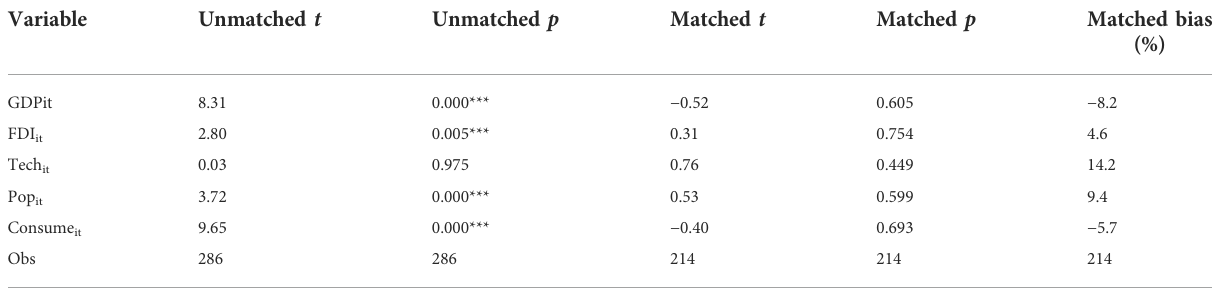
TABLE 3 The results of the PSM balance test (2017).